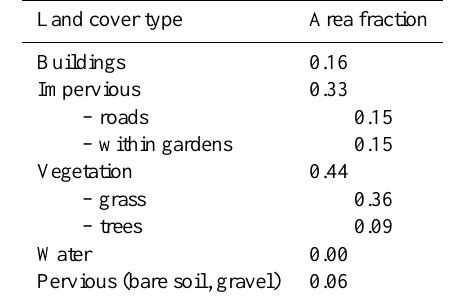
Table 1. Land cover within a radius of 500m around the flux mast. Land cover not classified by these classes comprised less than 0.5% of the total area. “Trees” includes all vegetation not classified as grass (i.e. includes hedges, shrubs, small